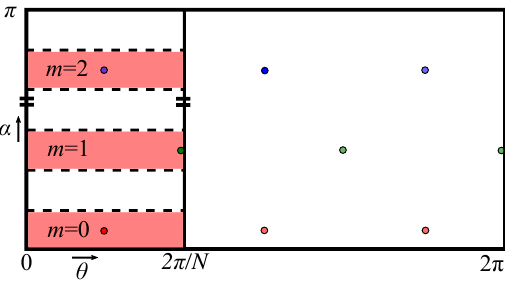
Figure 6 . Individual B k;m blocks give rise to one of the shaded regions of kinematic space. The corresponding geodesics from (cid:12)gure 5 are shown as points. The gaps are (cid:12)lled out by including con- tributions from the orientation reversed blocks with (cid:30) 1 < (cid:30) 2 . These correspond to the orientation reversed versions of the geodesics in (cid:12)gure